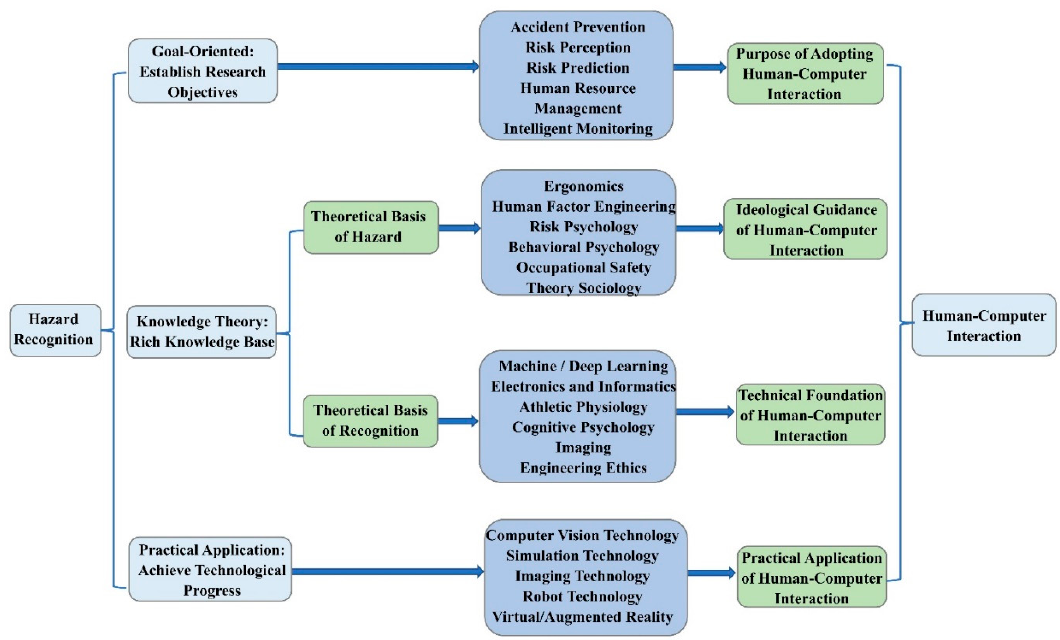
Figure 9. Research framework: from hazard recognition to HCI.